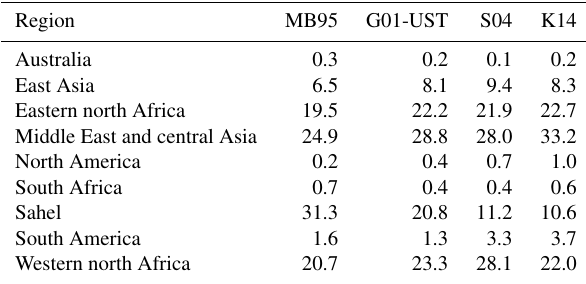
Table A1. Percentage contributions of different dust source regions (definitions as in Kok et al., 2021b) to global annual dust emissions with the four presented configurations.